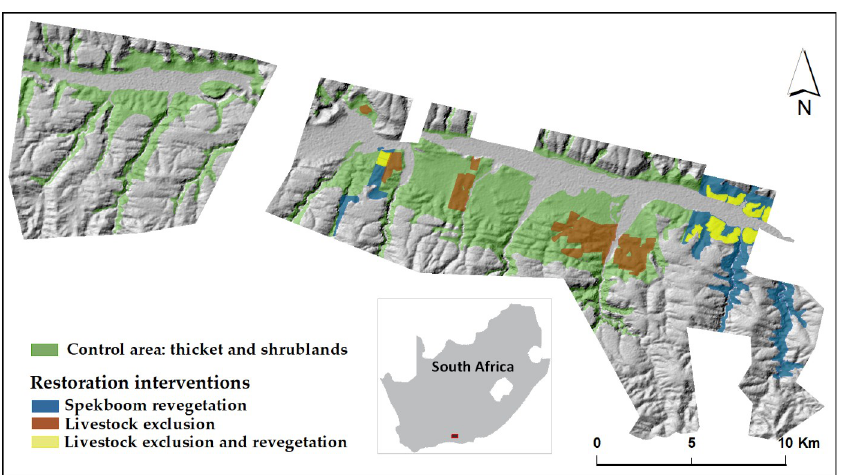
Fig 1. Restoration intervention sites in the in the Baviaanskloof Hartland Bawarea Conservancy study area in South Africa. Shading indicates topographic relief.